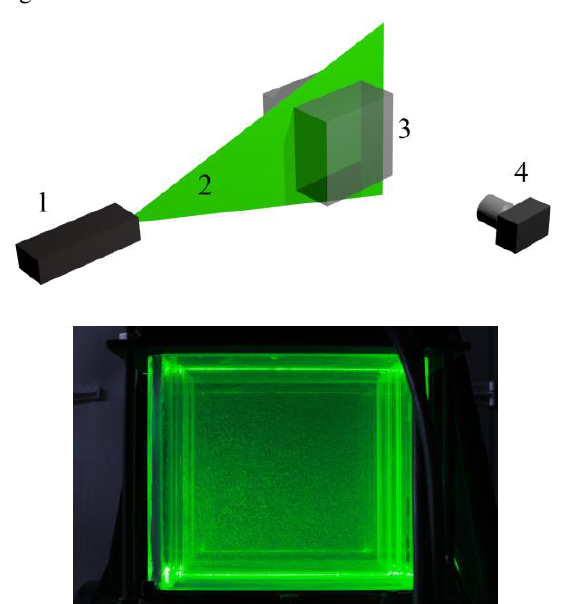
Fig.1. General scheme of the experiment: 1- laser, 2 – laser plane, 3 – benchmark, 4 – camera (top) and separate image taken with a long exposure (3 sec) representing the main flow pattern in system (bottom).